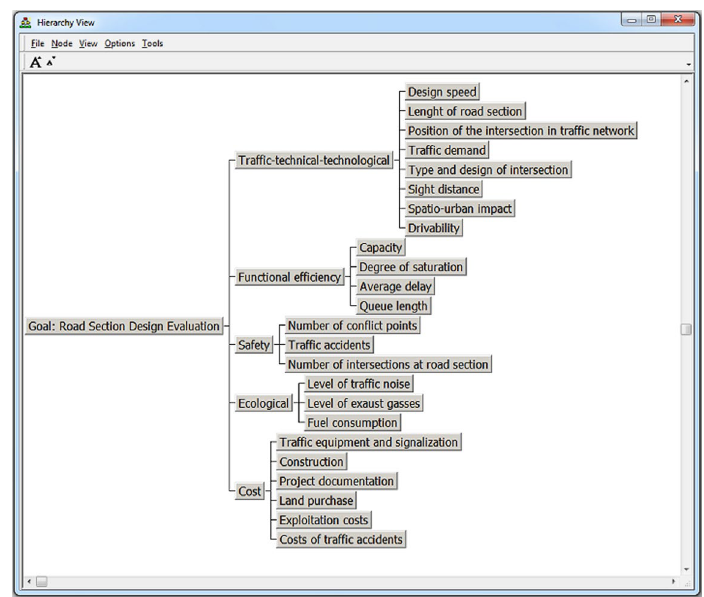
Fig. 3. Hierarchy structure of the AHP